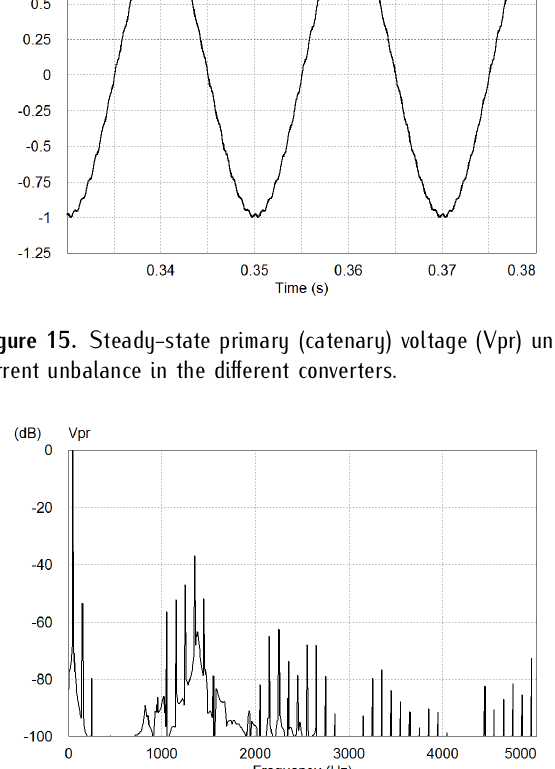
Figure 16. Frequency spectrum of the primary voltage (Vpr) showing components around twice the switching frequency.